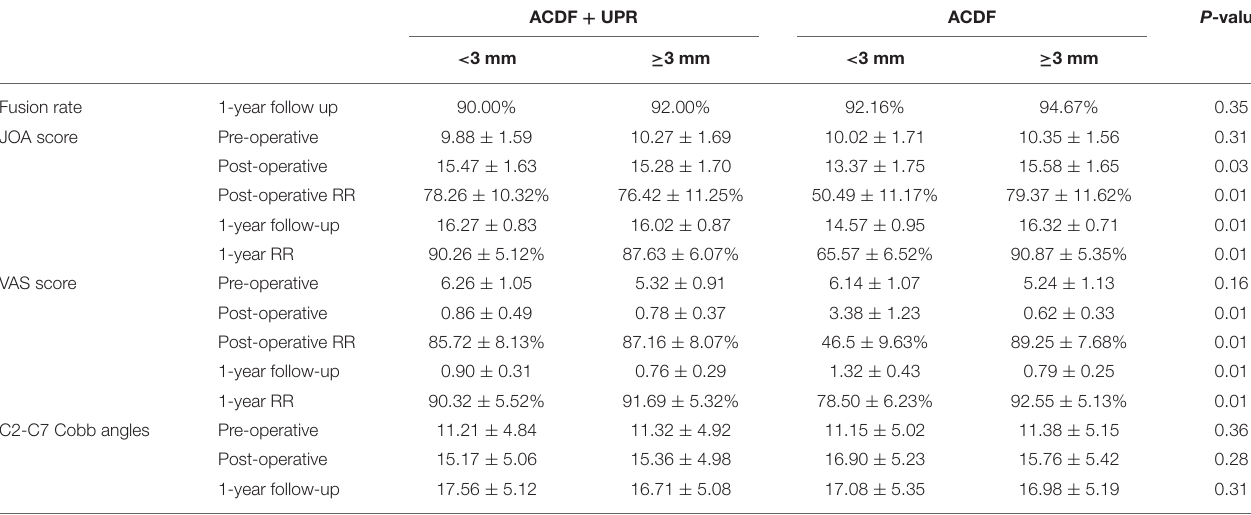
ACDF, anterior cervical discectomy and fusion; UPR, uncinate process resection; JOA, Japanese orthopedic association; VAS, visual analog scale; RR, Recovery rate. P < 0.05 is considered as significant.